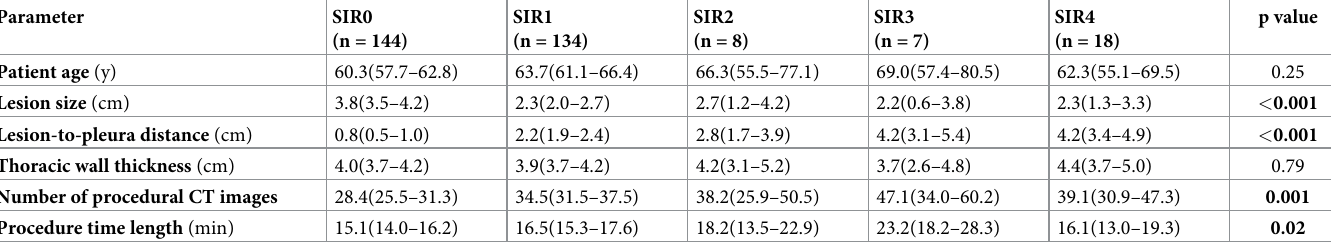
Table 2. ANOVA results of continuous parameters in relation to SIR classification (n = 311).